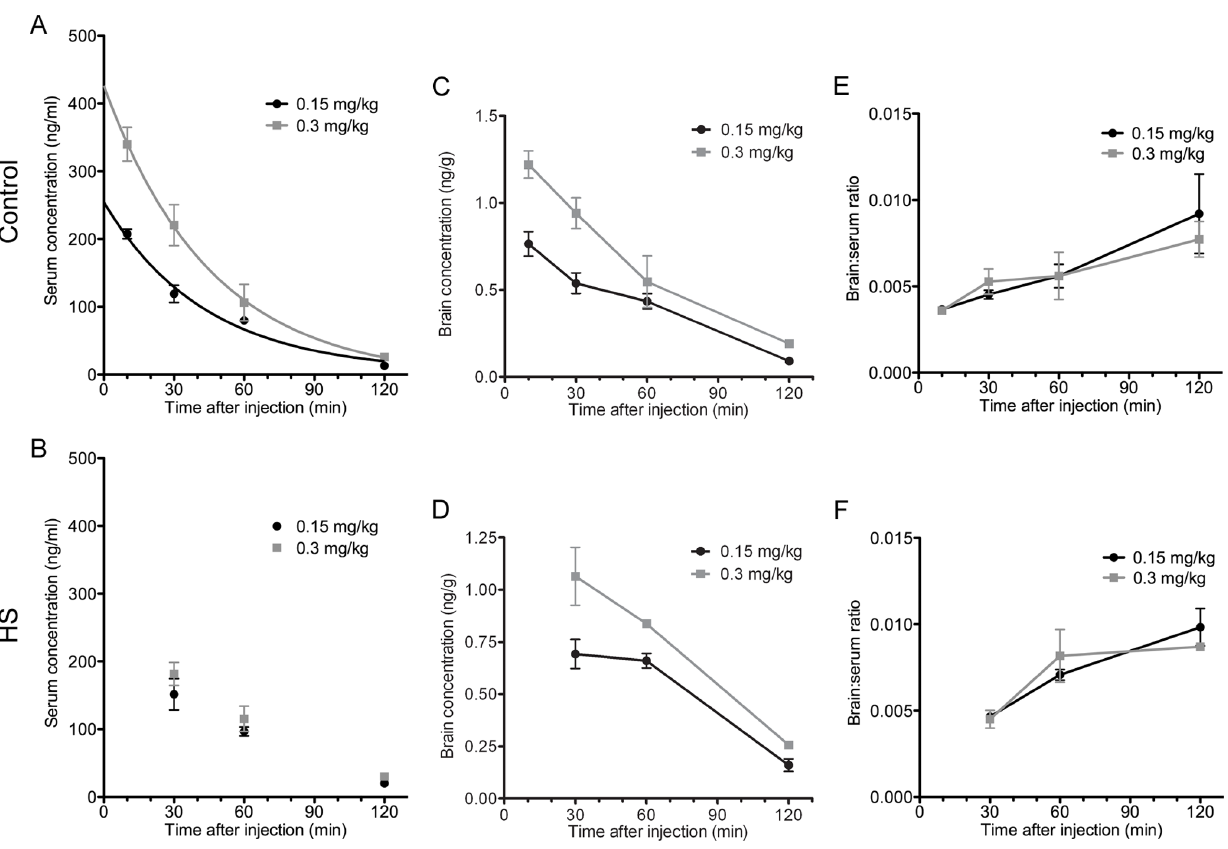
Figure 4. Bumetanide serum and brain levels, and brain:serum concentration ratios in control and hypoxic rats. Serum bumetanide levels in rats after hypoxia-induced seizures (HS, B) and in littermate controls (A) were plotted for the low (0.15 mg/kg) and high (0.3 mg/kg) bumetanide doses. In controls, average elimination half-lives of 29.9 min (low dose) and 31.6 min (high dose) were calculated using GraphPad Prism. Best-fit values were calculated assuming a one-phase exponential decay. Brain levels for control (C) and HS (D) rats were plotted for the low and high bumetanide doses. Plots of the brain:serum concentration ratios (E, F) show that bumetanide was eliminated more slowly from the brain than from serum. Mean 6 SEM. Error bars indicate SEM.